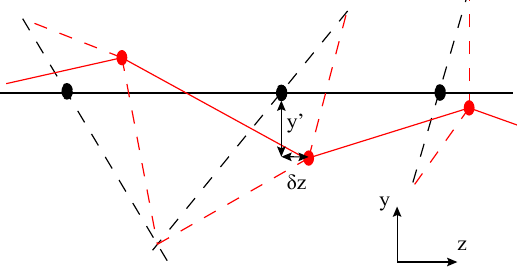
Figure 6. Nonaffine deformation by axial displacement δ z of the primary filament (drawn as a solid line, horizontally) and subsequent transverse deflection y (cid:48) of the crosslinks to restore the segment lengths of the other filaments (dashed lines), to first order in δ z ). Circles are crosslinks before and after